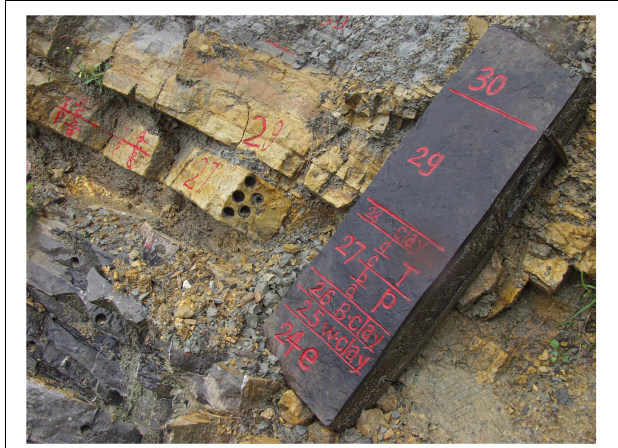
FIGURE 4 | The GSSP point for the base of the Induan Stage (=base of Triassic, =base of Mesozoic) at Meishan in southern China. As the tablet on the right of the photograph indicates, the GSSP for the base of the Triassic is the base of bed 27c. Photograph courtesy of Shuzhong